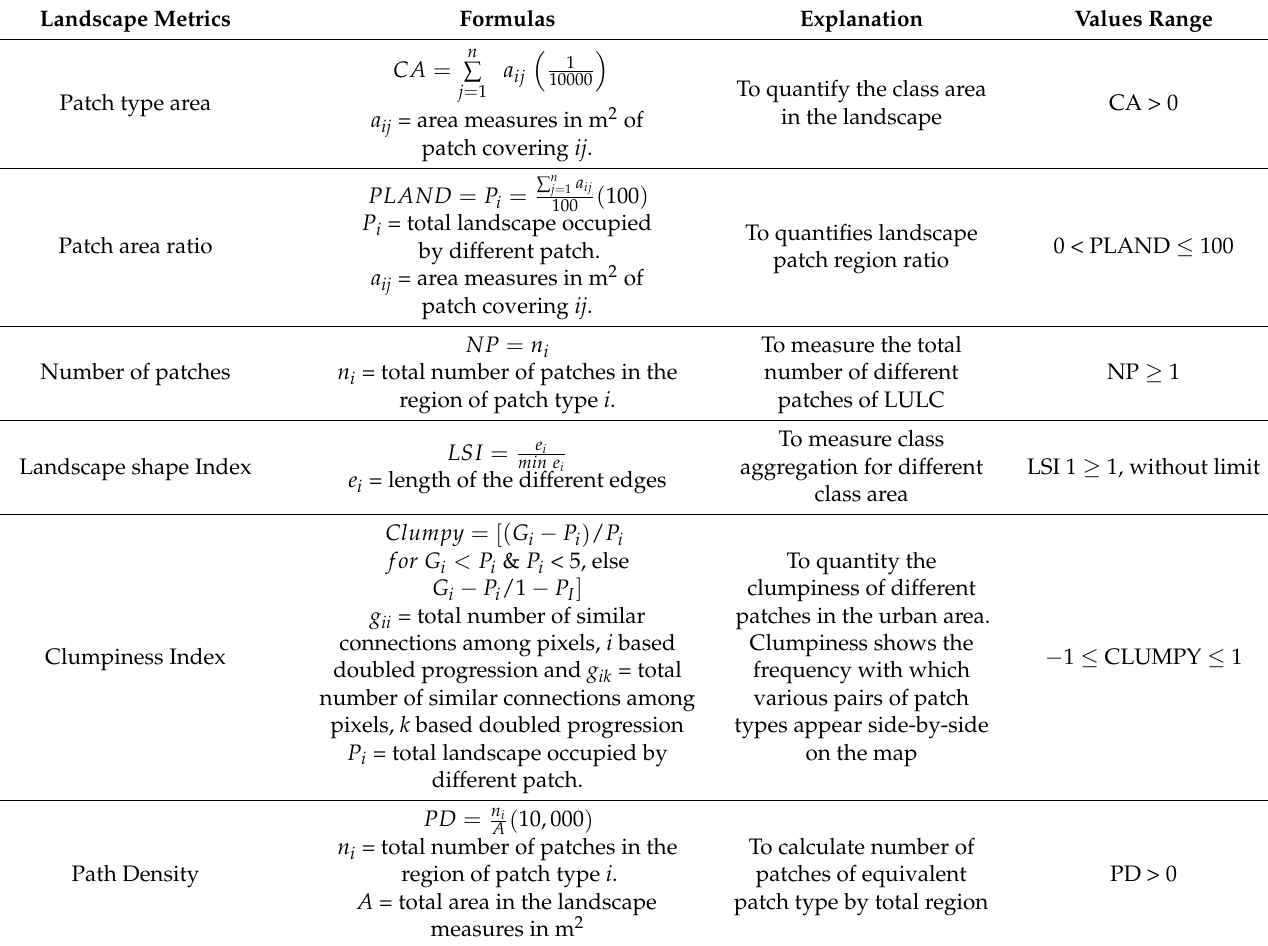
Table 3. Spatial metrics calculated to examine the landscape pattern information [55,57,58]. Landscape Metrics Formulas